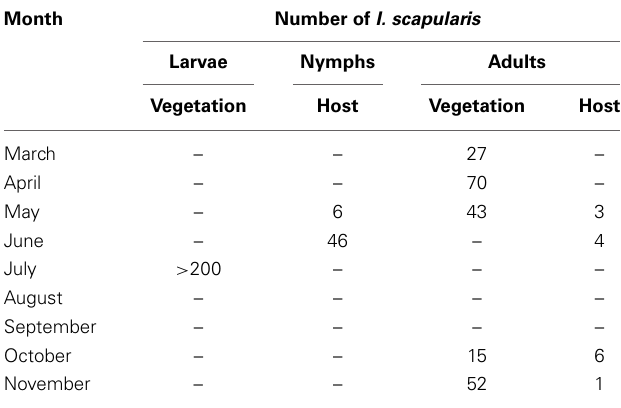
Table 2 | Tick survey at Tiverton Township in